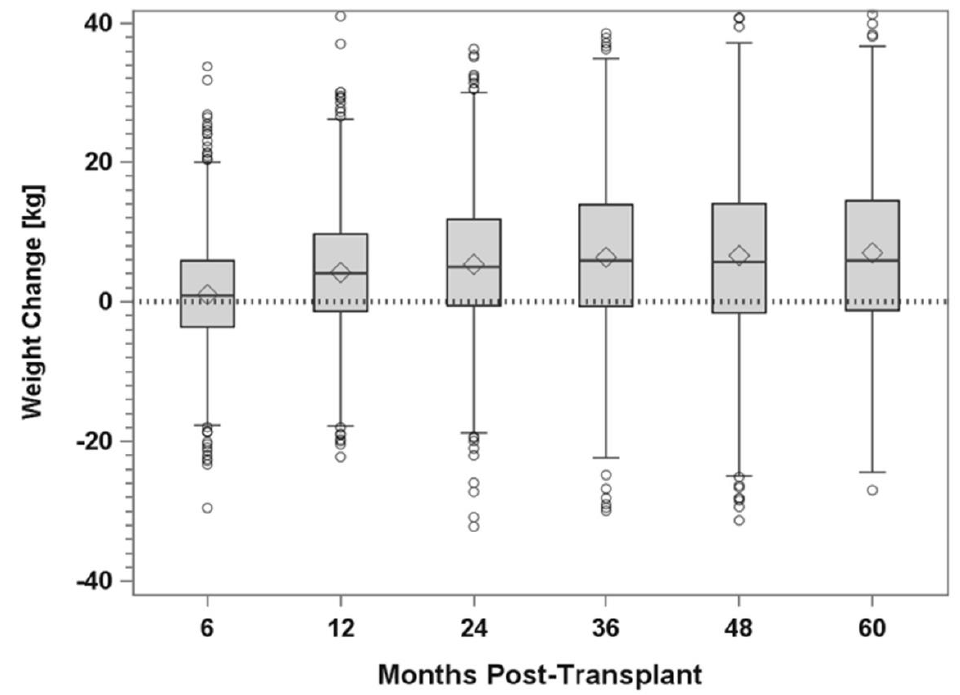
Figure 8. Weight change over time in PTx recipients identified as having T2DM for US cases as reported to the IPTR.